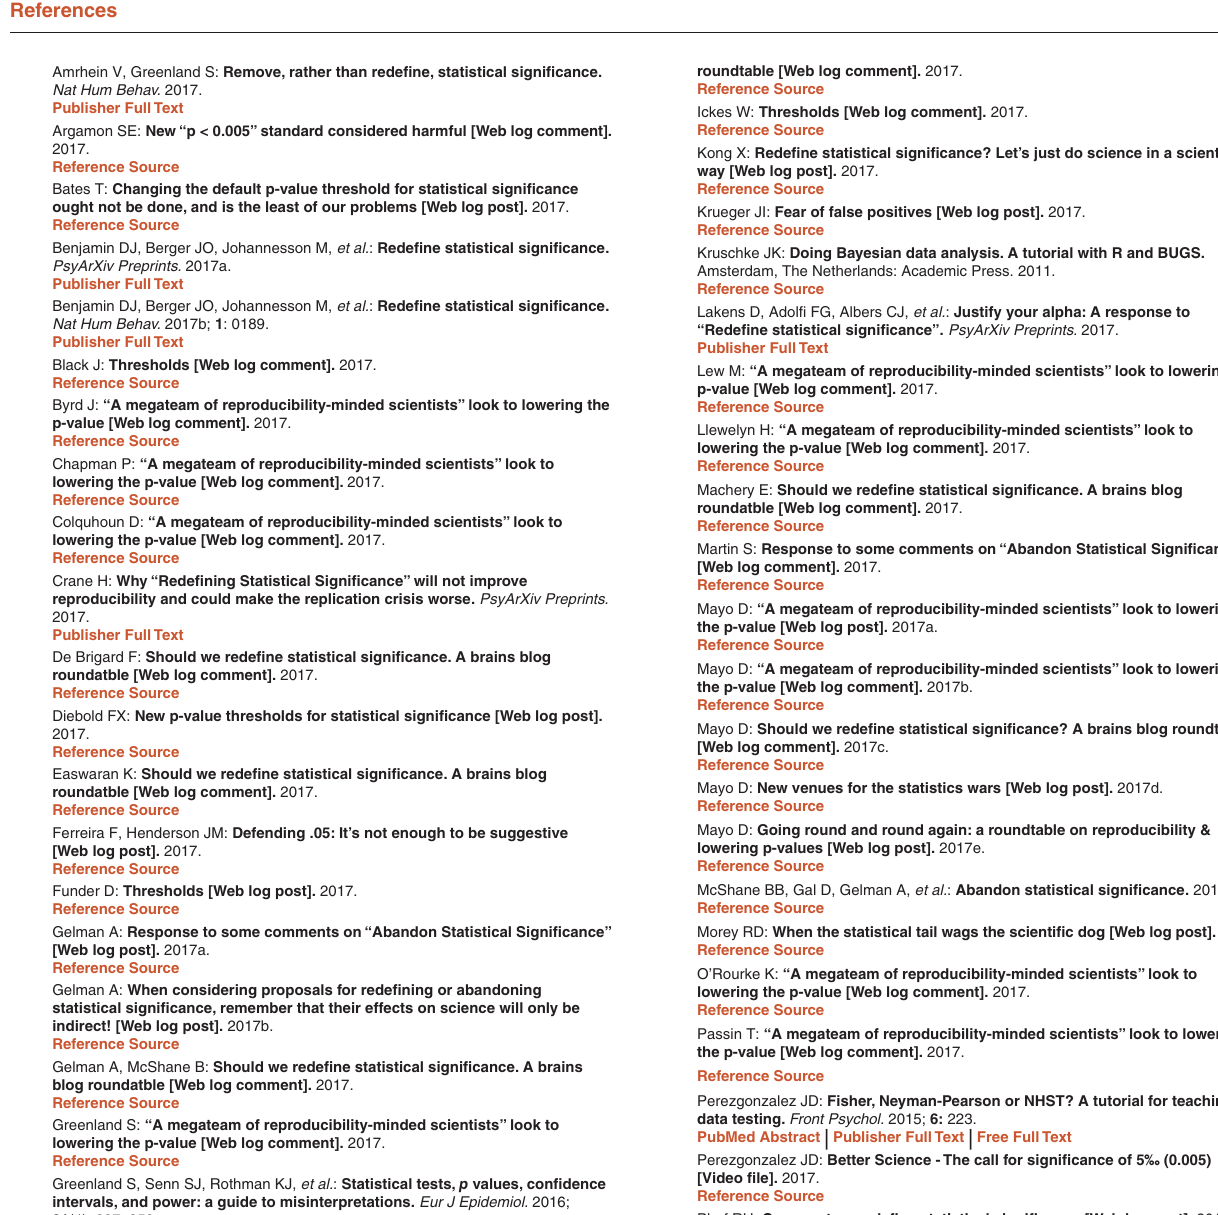
Supplementary file 1: Parallel statistical analysis via JASP . Example of data analysis using both frequentist (Fisher) and Bayesian (Jef- freys) approaches. Click here to access the